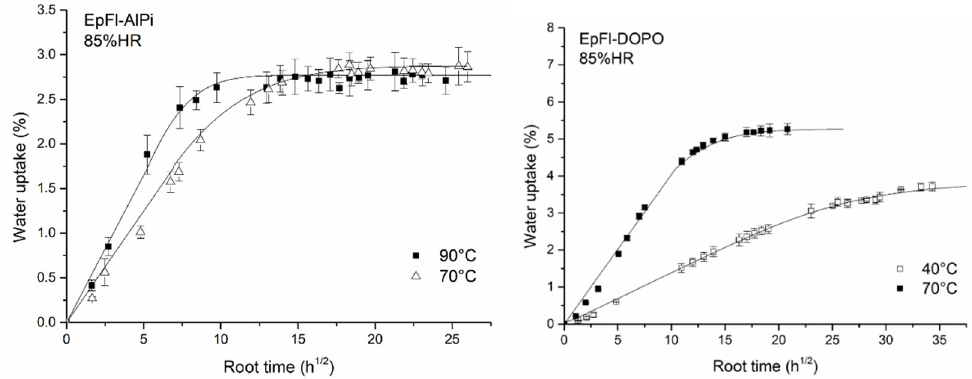
Figure 4. Water sorption kinetics of EpFl-AlPi at 90 °C and EpFl-DOPO at 40 °C.